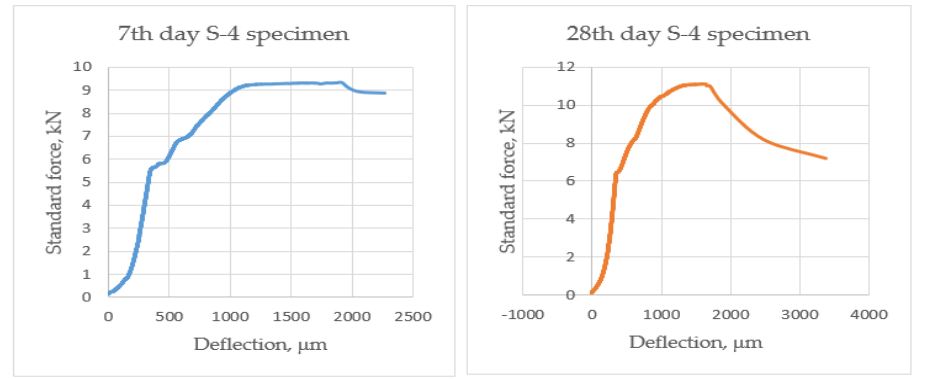
Figure 11 Crack behavior of sample S-4 after 7 and 28 days of hardening.